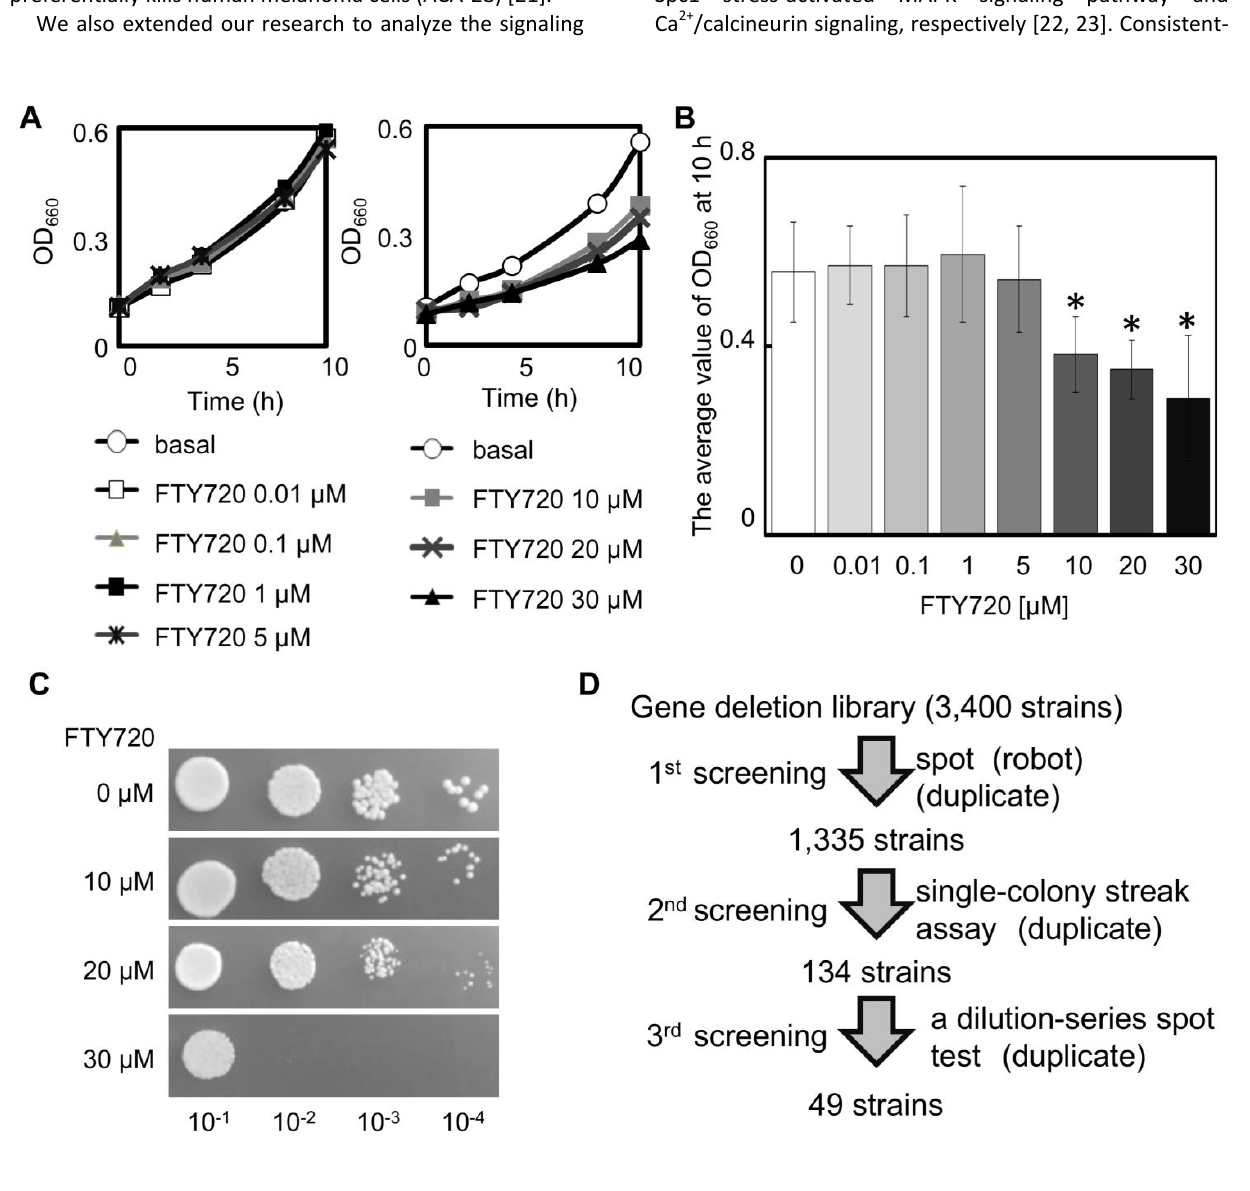
OPEN ACCESS | www.microbialcell.com